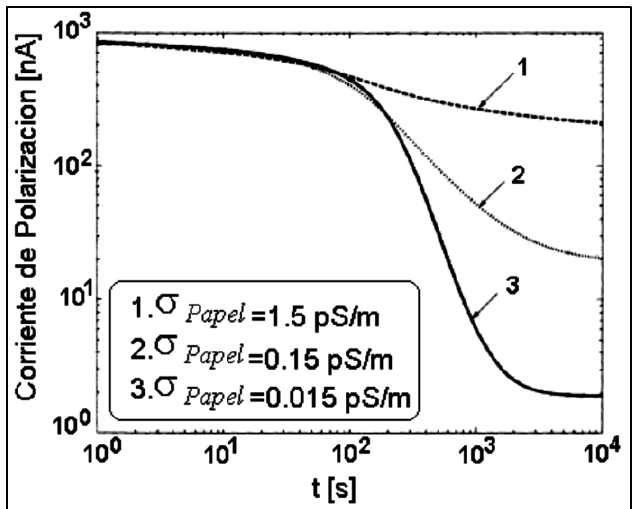
Figura 10: Variaciones de la corriente de polarización para varias conductividades del papel aislante.